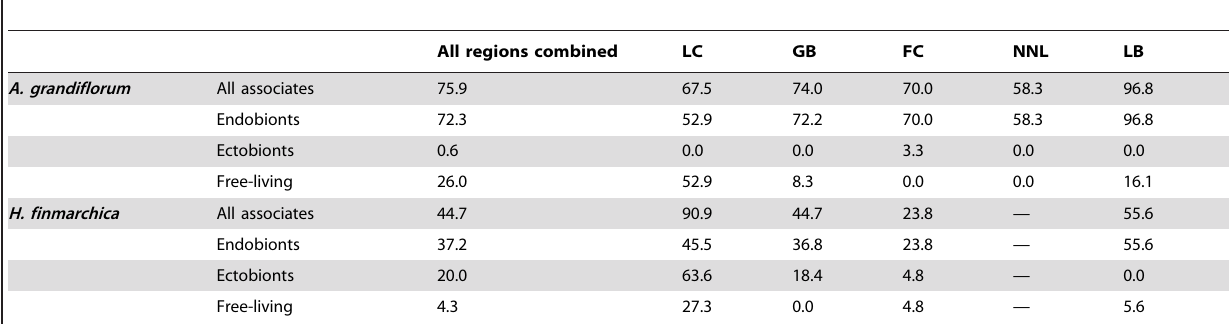
Table 4. Prevalence of associates on colonies of Anthoptilum grandiflorum and Halipteris finmarchica in the different geographic regions (as percent colonies harbouring